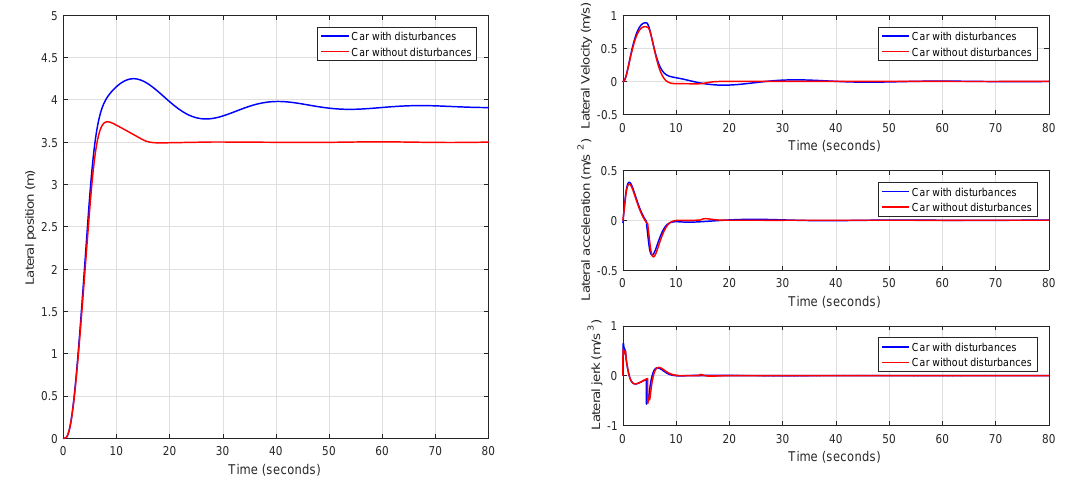
Figure 34. Validation of the controller with variable band and optimal reset with an external disturbance in CarSim.